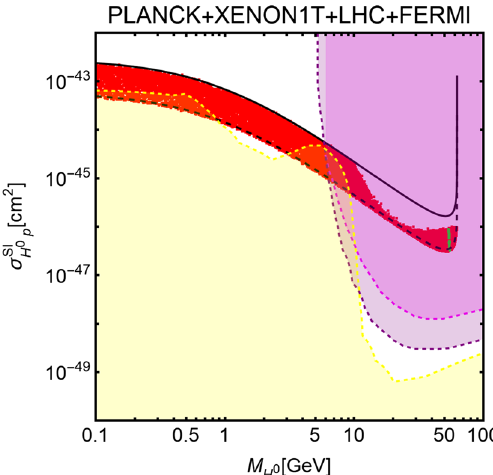
Fig. 14 Model points (red) of the inert doublet model satisfying all the experimental constraints with the exception of the DM relic density, and with a Higgs invisible branching fraction comprised between 2.5 and 11%. The solid and dashed lines illustrate the expected contours obtainedwiththeabovetwovaluesofthebranchingratiointheeffective Higgs-portalmodelforascalarDM.Thesmallareawiththegreenpoints complies in addition with the correct relic density. The magenta/purple and yellow regions represent the sensitivity regions of the XENONnT and DARWIN experiments and the neutrino